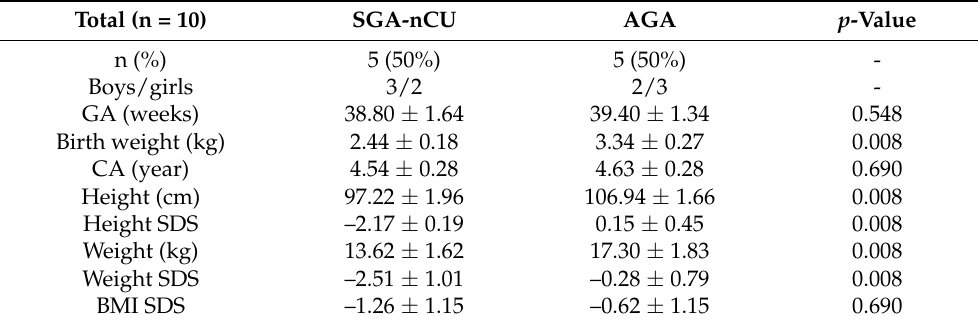
Table 1. Clinical characteristics of the subjects who underwent serum miRNA analysis.